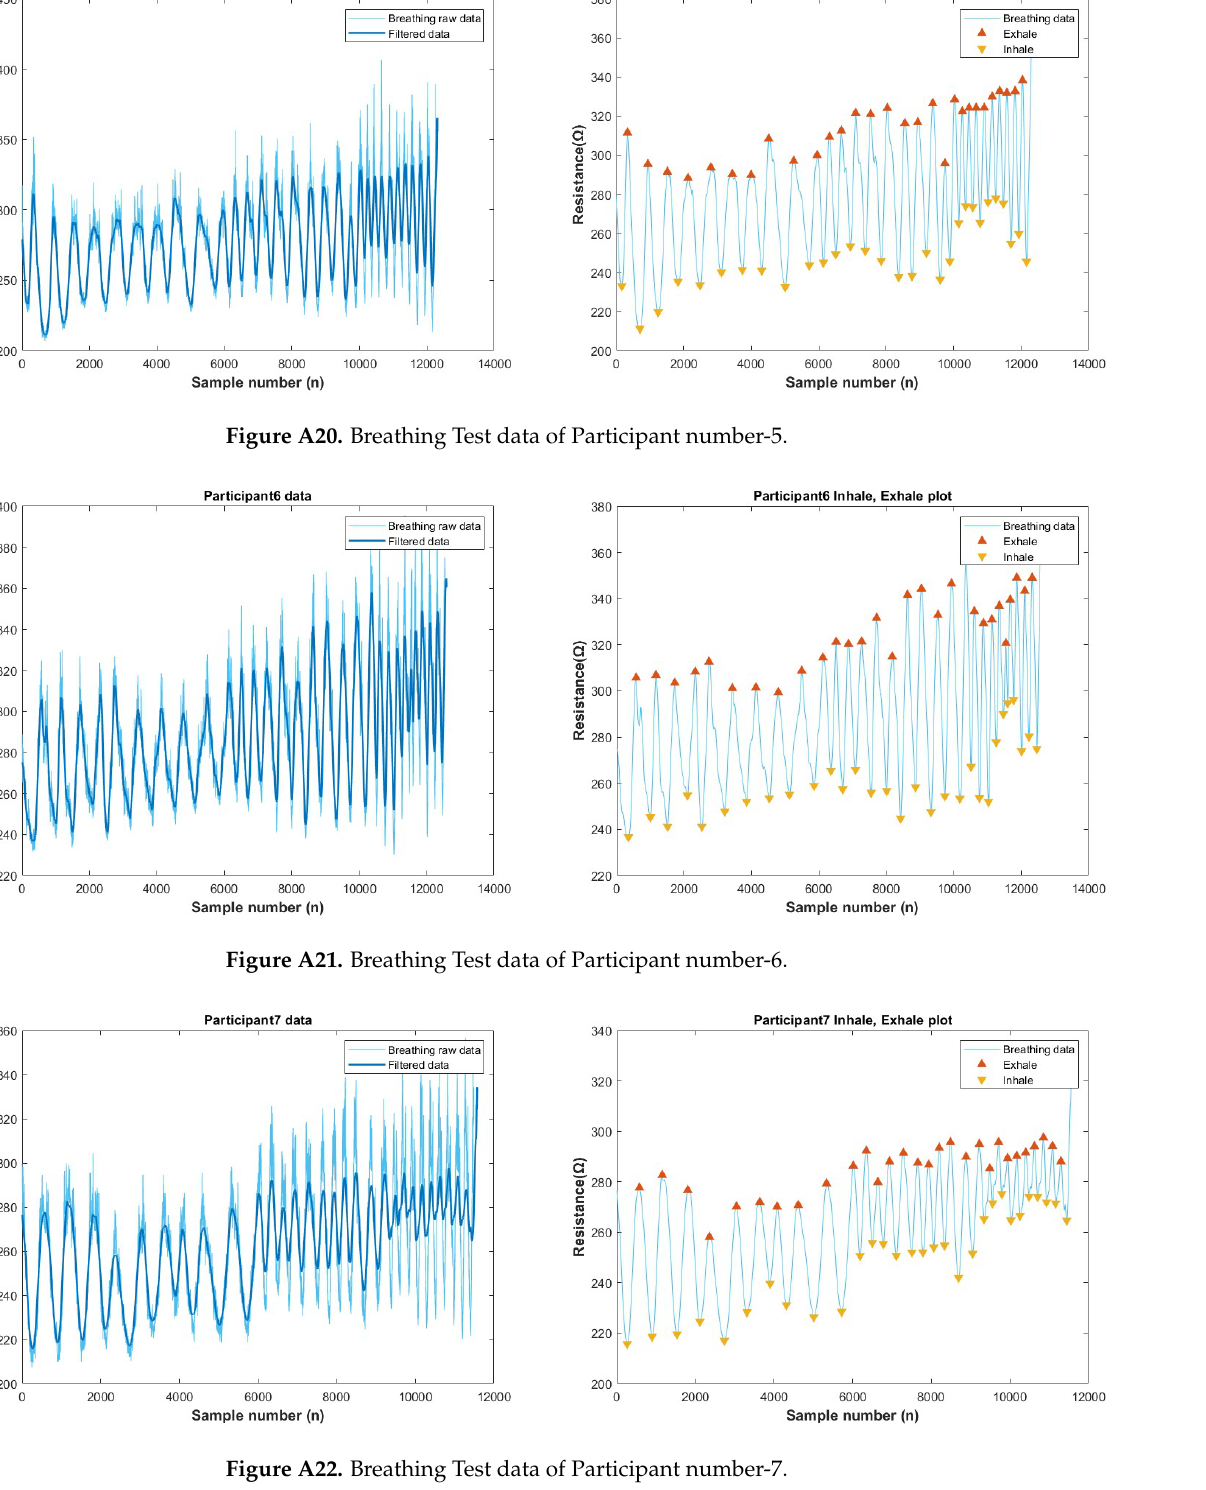
Figure A22. Breathing Test data of Participant